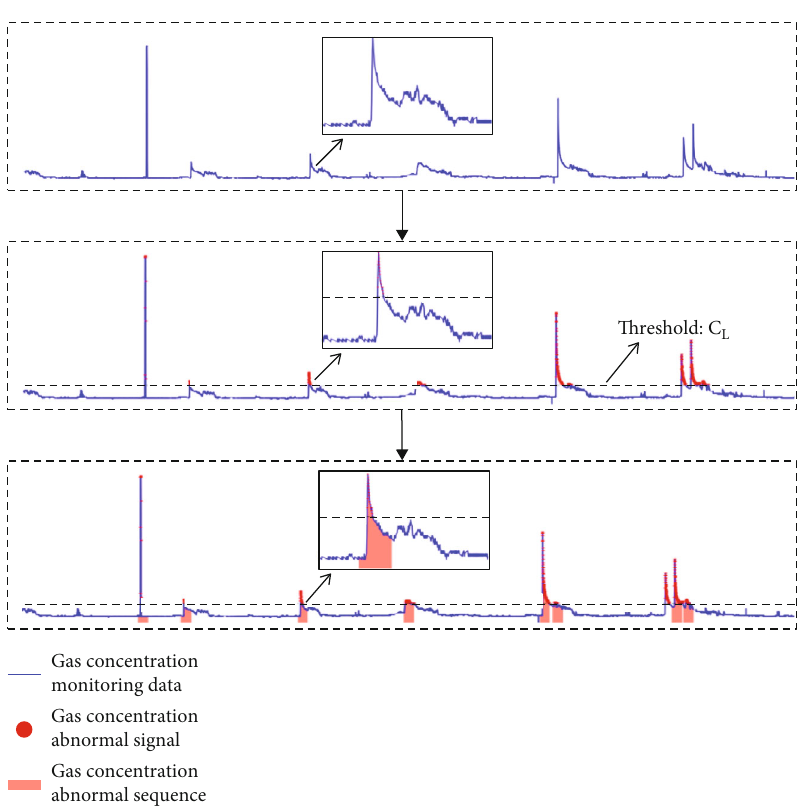
Figure 2: The interception of abnormal gas concentration